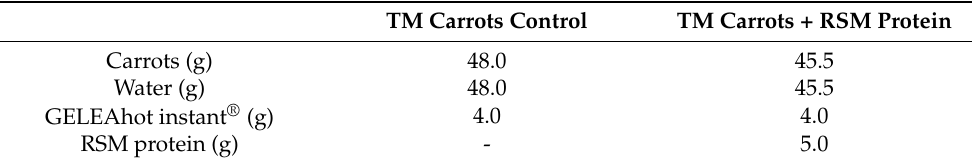
Table 3. Recipe of TM carrots without (control) and with the addition of RSM protein isolate. Values are expressed as g 100 g − 1 of fresh product.